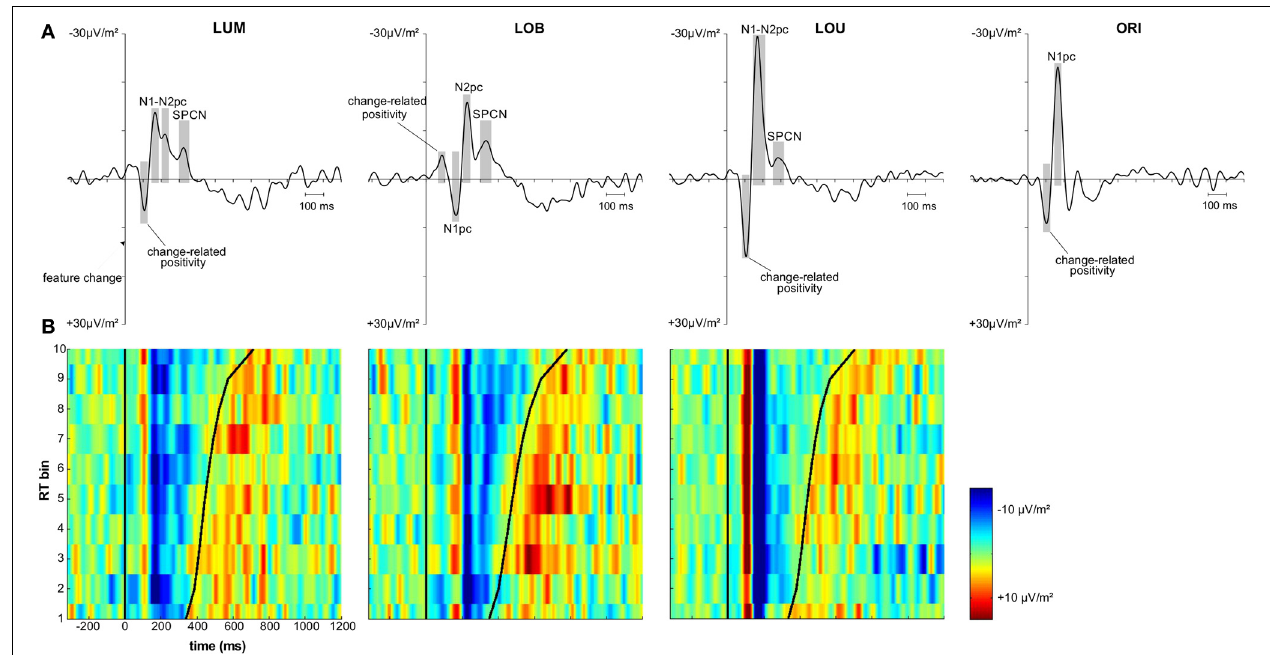
FIGURE 3 | Grand average and vincentized ERLs (PO7/PO8) for all change conditions. (A) Depicts the grand average ERL data for the LUM, LOB, LOU, and ORI conditions. The components of interest (i.e., change-related positivity, N1pc, N2pc, and SPCN) were marked for each change condition. Both N2pc and SPCN were only analyzed in the target change conditions. (B) Depicts the vincentized ERLs for the LUM, LOB, and LOU conditions based on a color scale (negativity = blue, positivity = red) and the same time window also used for the grand average data. The bold